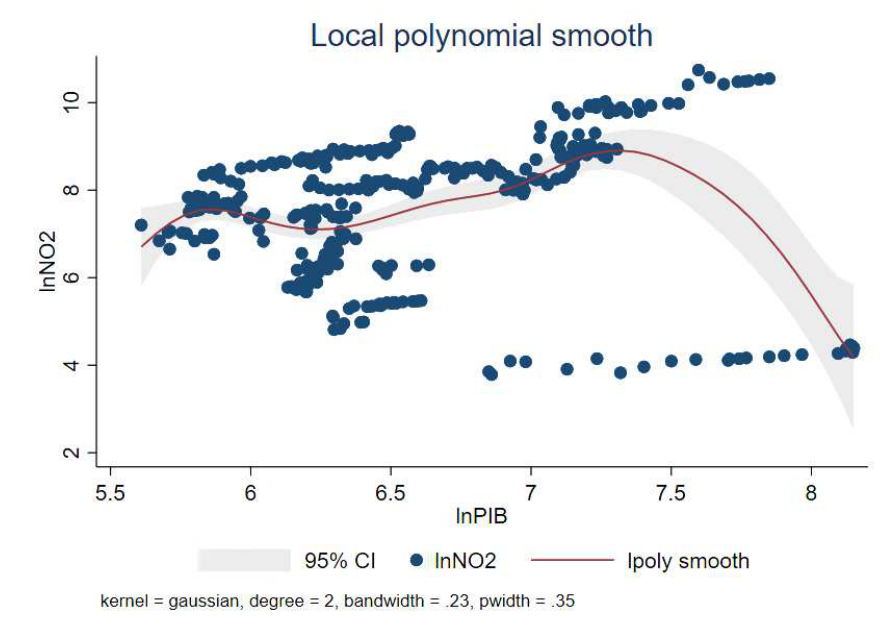
Figure 2. Partial adjustment of the income-NO2 emission relationship